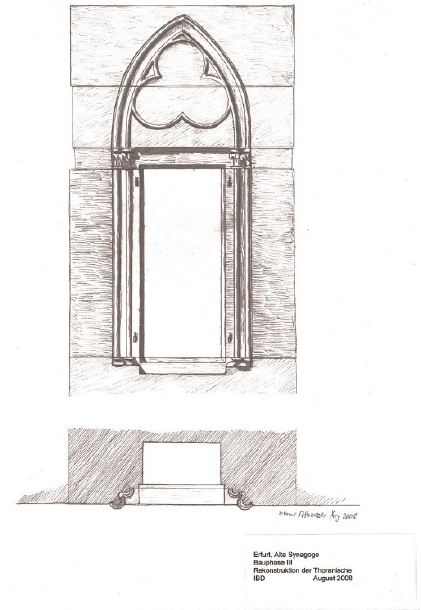
Figure 4. Reconstruction of the Torah Ark (Elmar Altwasser, used with permission).